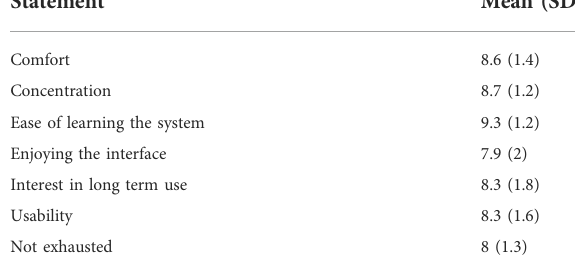
TABLE 1 NASA Task load for studies one to four measured on six subscales each on a 20-point Likert scale.